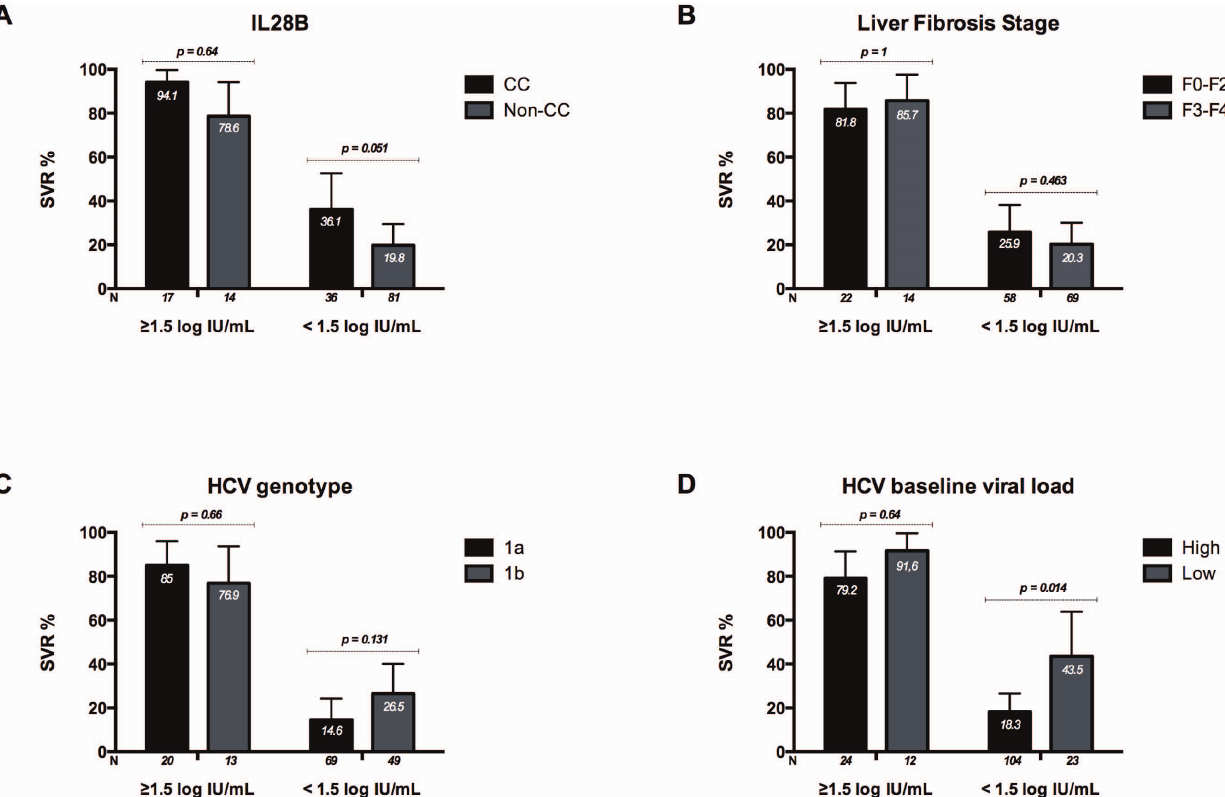
Figure 1. Comparison of Positive Predictive Value (PPV) for Sustained Virological Response (SVR) of viral decline of $ or , than 1.5 log IU/mL at week 2 after start of therapy relative to IL28B genotype (CC versus non-CC) (Figure 1A), liver fibrosis stage (F0–F2 versus F3–F4) (Figure 1B), HCV genotype (1a versus 1b) (Figure 1C), and baseline HCV viral load ( $ 600,000 IU/mL versus , 600,000 IU/mL) (Figure 1D). P value was obtained using Fisher’s exact test or the chi-square